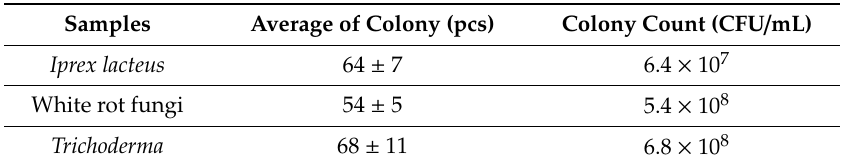
Figure 4. Plate counting of ( a ) Irpex lacteus , ( b ) white rot fungus, and ( c ) Trichoderma . Table 4. Colony counting results.